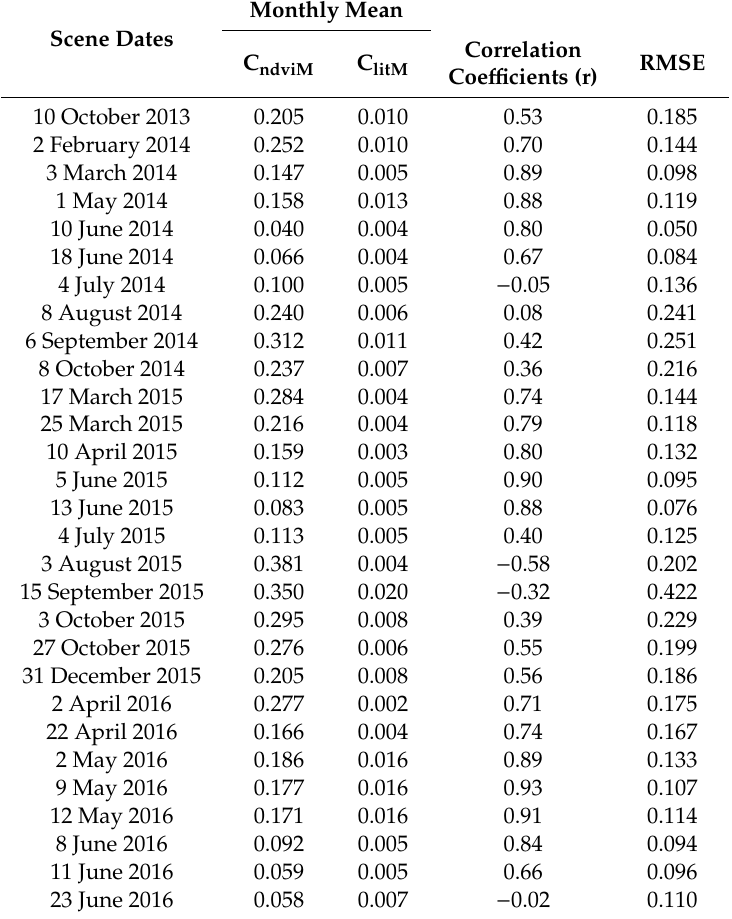
Table 4. Comparison between monthly C ndviM and C litM values represented by scene dates, for the entire study